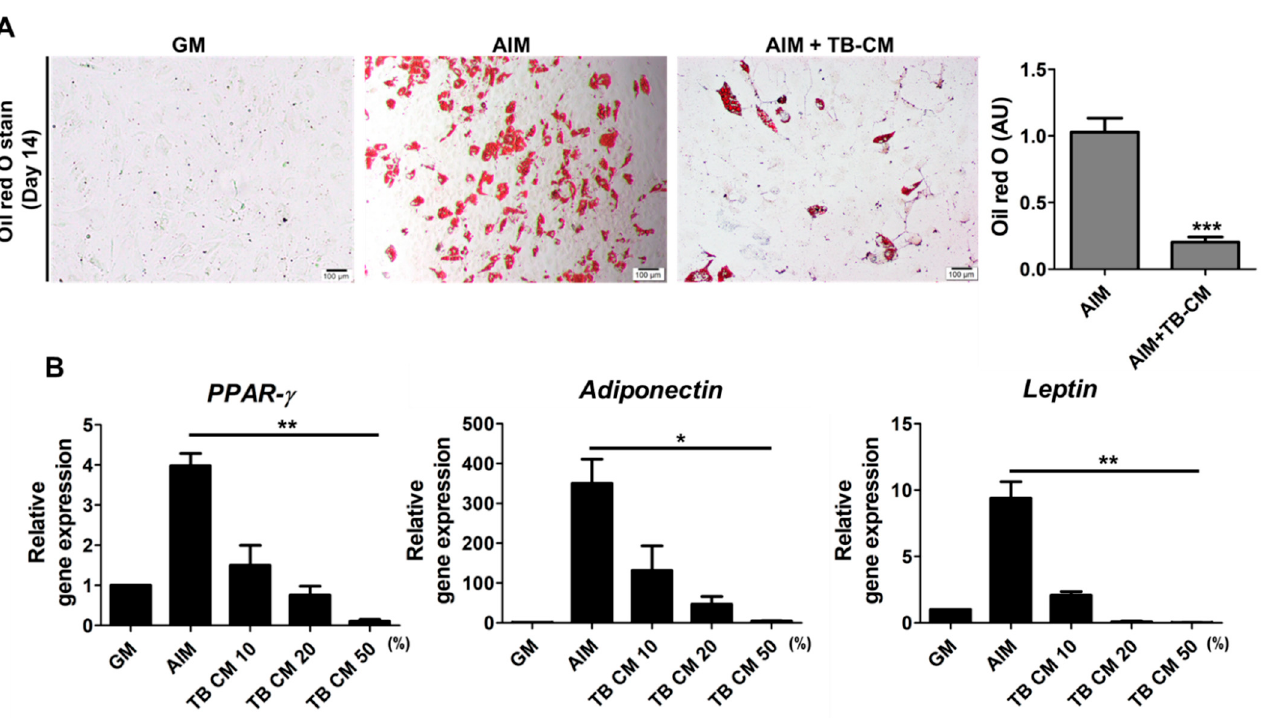
Figure 2. Trophoblast-derived conditioned medium (TB-CM) inhibits adipogenesis of mesenchymal stem cells (MSCs). ( A ) Oil red O staining showing the production of lipid droplets after the adipogenic differentiation of human MSCs upon culturing for 14 days in the adipogenic induction medium (AIM). The inhibitory effect of 50% TB-CM on the adipogenesis of MSCs was determined by the quantification of stained cells, as represented in the graph (AU, arbitary unit; *** p < 0.001). ( B ) The relative expression levels of genes encoding for PPAR-g, adiponectin, and leptin in the adipogenic MSCs treated with 10, 20, and 50% TB-CM for 14 days were determined by performing a quantitative reverse transcription-polymerase chain reaction. Data are represented as mean ± SD. p - values were obtained using analysis of variance; * p < 0.05 and ** p < 0.01.